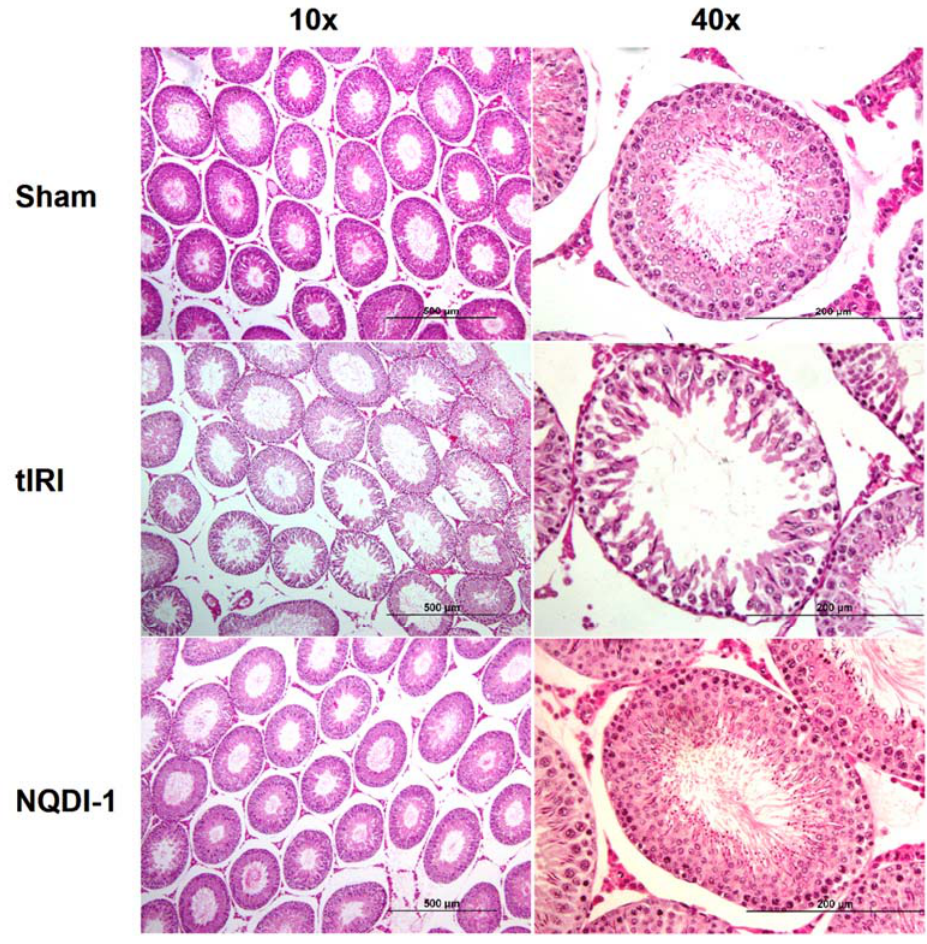
Figure 1. NQDI-1 protects against damage to testicular histology and spermatogenesis. hematoxylin and eosin (H&E)stained-slides were visualized under light microscopy revealing destruction in the Seminiferous Tubule (ST) structure accompanied by alterations in the germ cell layer arrangement after tIRI induction. In contrast, sham and NQDI-1 treated groups showed normal ST histology and proper cellular stages of spermatogenesis. Contralateral testes showed no significant di ff erence between the three animal groups. NQDI-1 (10 mg / kg) was i.p. injected 30 min post ischemia. Images were taken at 10x and 40x magnification with a scale bar of 50 μ m.